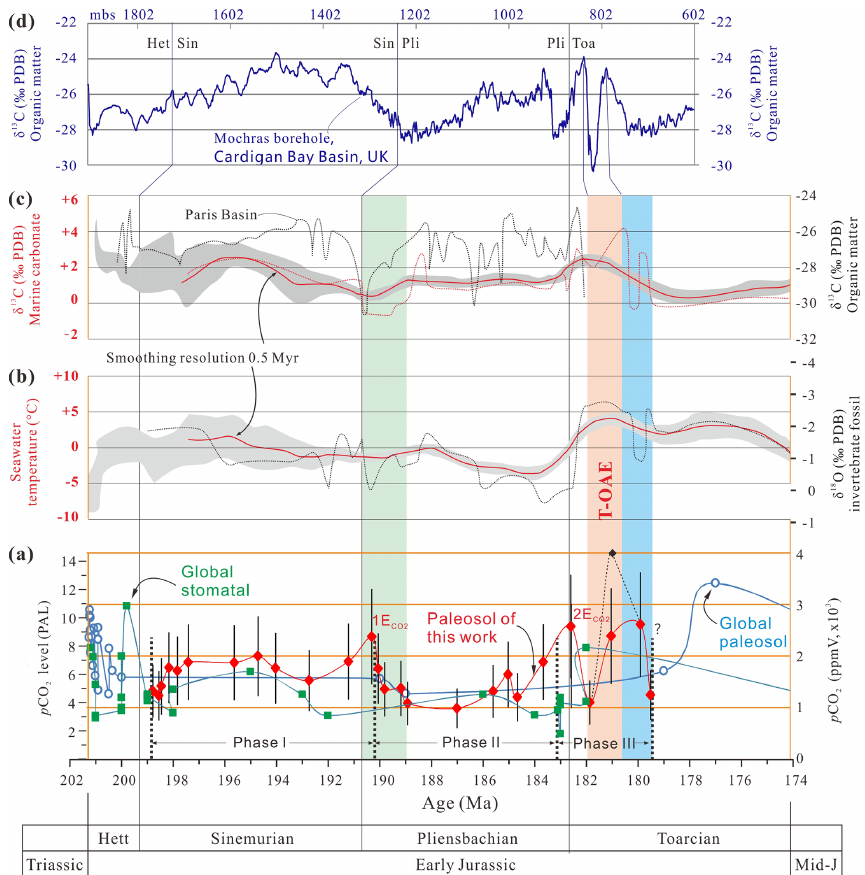
Figure 8. Comparison among the Early Jurassic p CO 2 , δ 13 C of marine carbonates and organic matter, δ 18 O of invertebrate fossils, and seawater temperature. Age model is from Cohen et al. (2013). (a) The p CO 2 values of this work and the composite p CO 2 by paleosol and stomatal index (Supplement Tables S6 and S7). Vertical bars are errors (1 σ ) of p CO 2 (Table S5). Errors are propagated using the Gaussian approach (Breecker and Retallack, 2014). Note that (1) p CO 2 = 4027ppmv (black solid diamond, sample J1z-20-01) if the δ 13 C r =− 29 . 0‰ at 181Ma, taken from Xu et al. (2018), in the case of other constant parameters. (2) The early published p CO 2 values from both carbon isotope of pedogenic carbonates and stomatal index of fossil plants (data refer to Tables S6 and S7) were very roughly dated using the average age of a lithostratigraphic formation or group, with which the uncertainty can be up to 10Myr, leading to the difficulty of precise and accurate p CO 2 correlation in pace, frequency, and event. (b) The δ 18 O and seawater temperature (dotted black line) of marine invertebrate fossils compiled from Rosales et al. (2001), Jenkyns et al. (2002), Bailey et al. (2003), van de Schootbrugge et al. (2005), Gómez et al. (2008), Metodiev and Koleva-Rekalova (2008), Suan et al. (2008), Korte et al. (2009), Dera et al. (2011), and Gómez et al. (2016). (c) The dotted red line shows δ 13 C of marine carbonates in the western Tethys Ocean, composed from Jenkyns and Clayton (1986, 1997), Hesselbo et al. (2000), Dera et al. (2011), Arabas et al., 2017; the dotted and solid black line δ 13 C of organic matters from Paris Basin, France (Peti et al., 2017). Smoothed δ 18 O and seawater temperature (red curves) in (b) and (c) are following Dera et al. (2011). (d) The δ 13 C of organic matter from the North Atlantic taken from the Mochras borehole, Cardigan Bay Basin, UK (Xu et al., 2018; Storm et al., 2020), with a seven-point average smoothing against depth